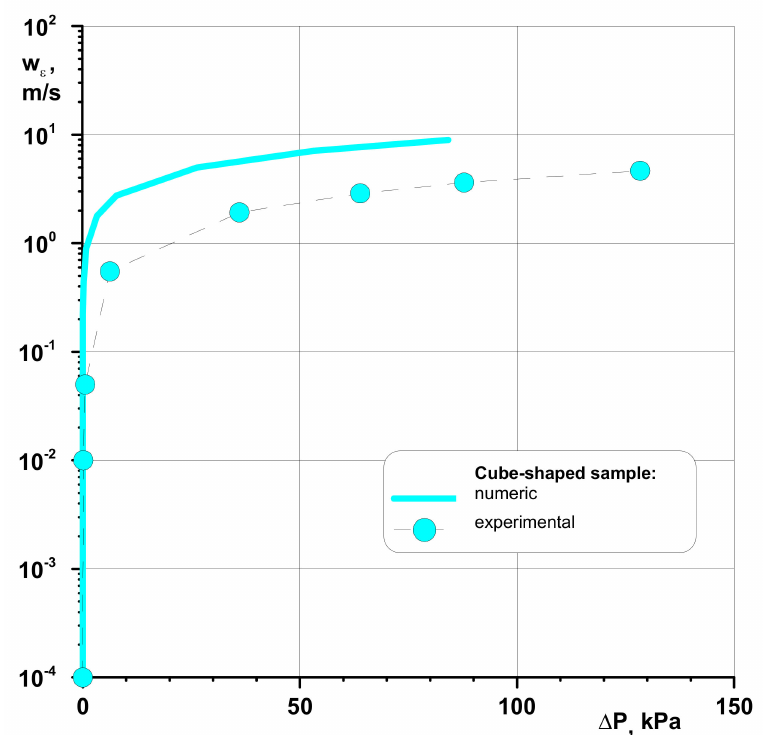
Figure 11. Summary of experimental and numerical results for porous